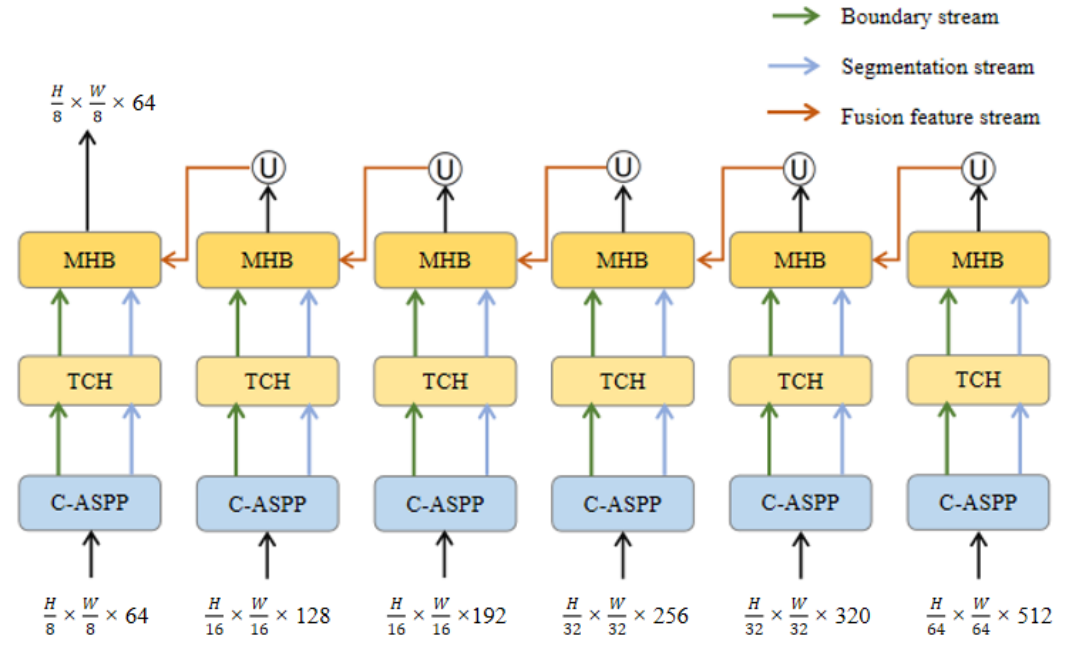
Figure 5. Cross-modal contextual feature fusion module.